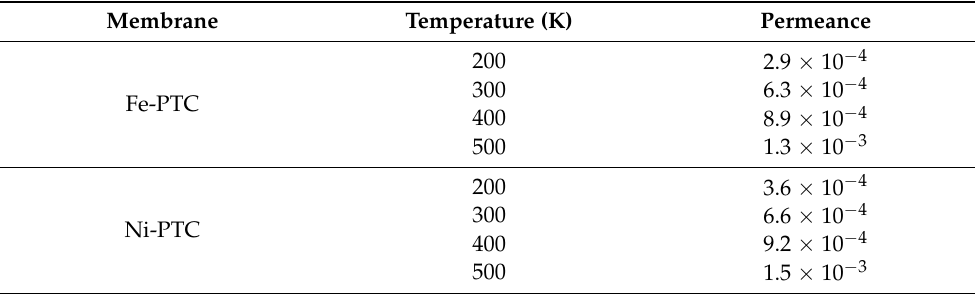
Table 3. He permeance (mol s − 1 m − 2 Pa − 1 ) at the temperature range of 200–500 K.